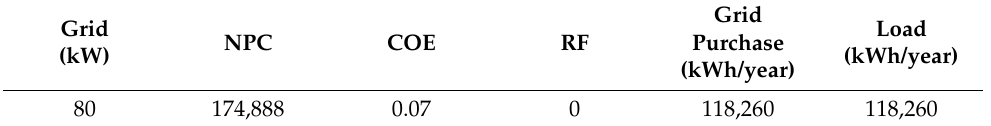
Table 5. Economic characteristics, yearly power generation and consumption of grid alone systems.